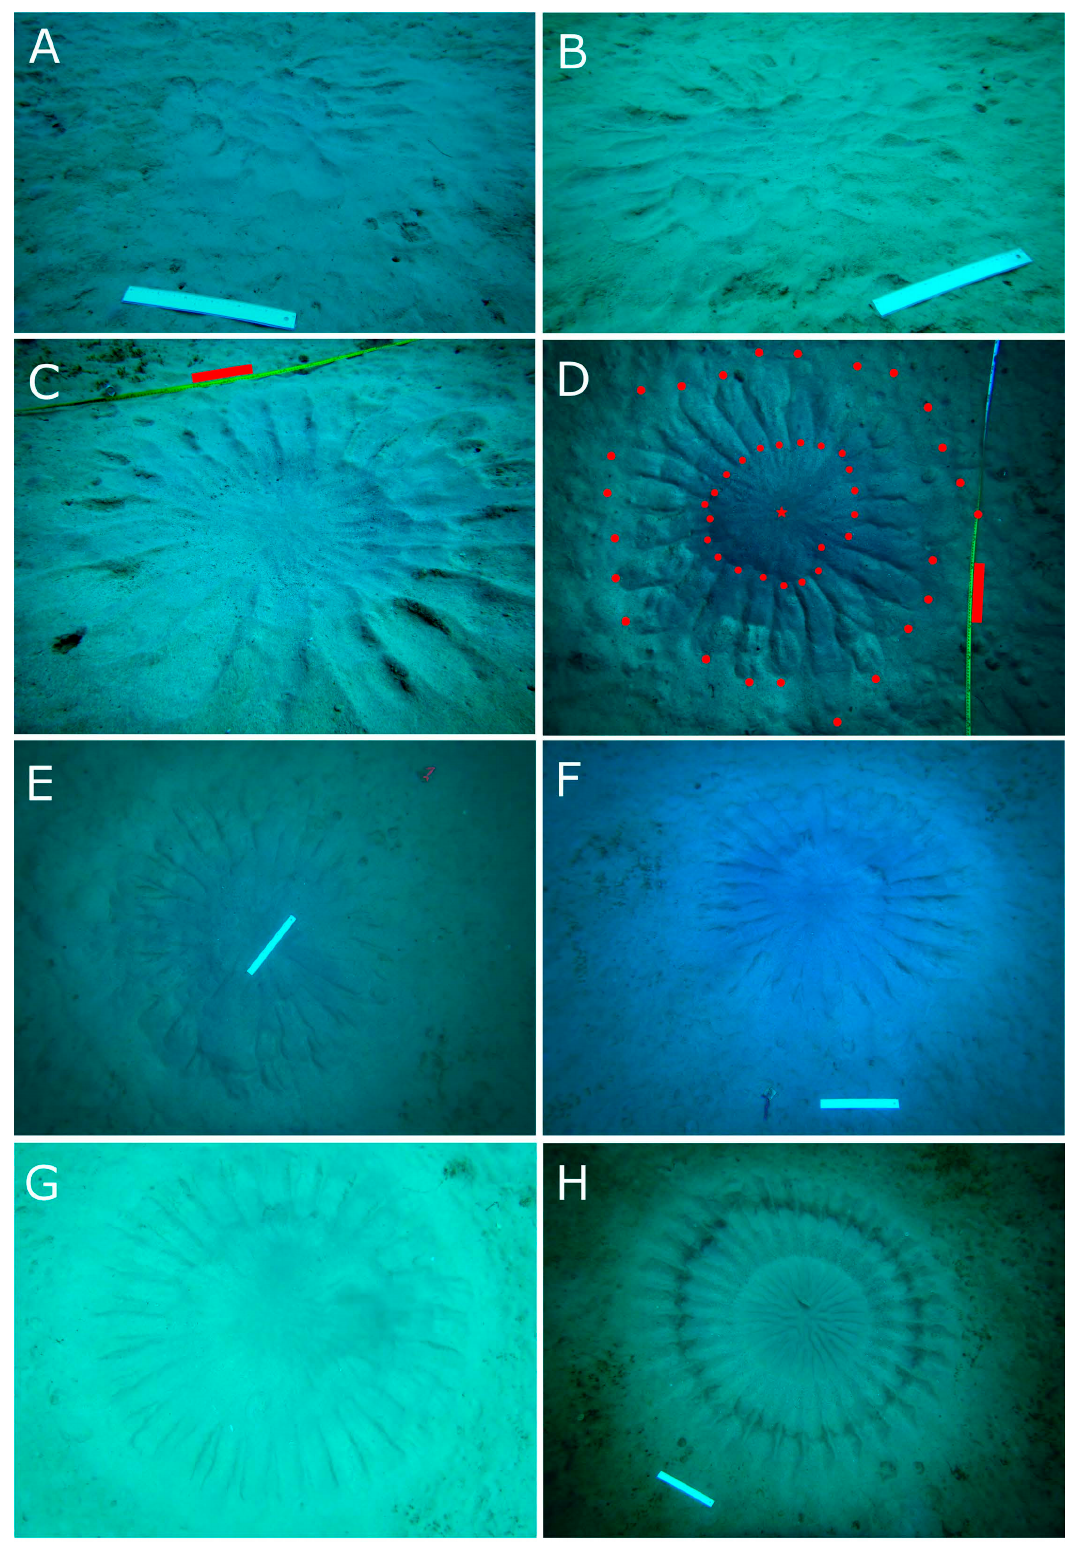
Figure 1. Development of mystery circle constructed by the pufferfish Torquigener albomaculosus . The earliest stage ( A , B ), early stage ( C – F ), middle stage ( G ), and final stage ( H ) of construction are shown. See details in text and Table 1. Scale length in ( A , B , E , F , H ) is 30 cm. Red bar in ( C , D ) represents 20 cm. See text for red star and solid circles in ( D ). Photo by Hiroshi Kawase.